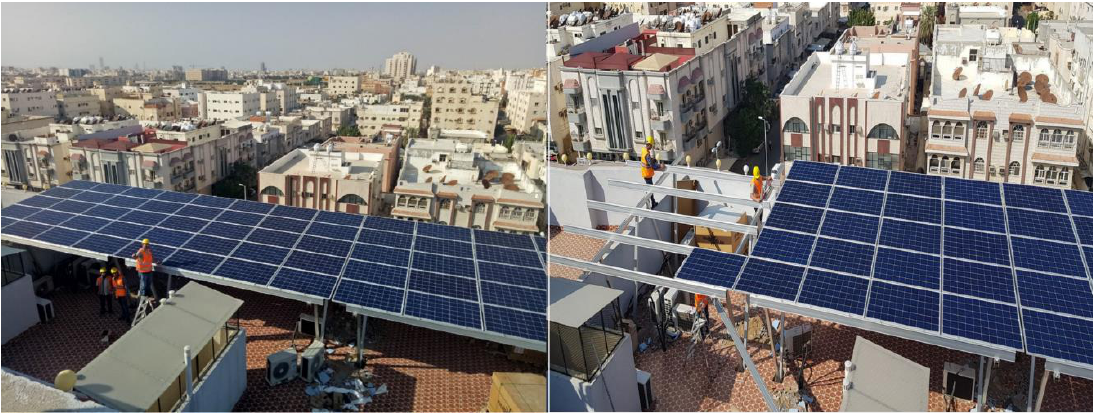
Figure 24. A recent PV-canopy system installed on the roof of an apartment building in Jeddah (Courtesy of Solar Land sle.sa).